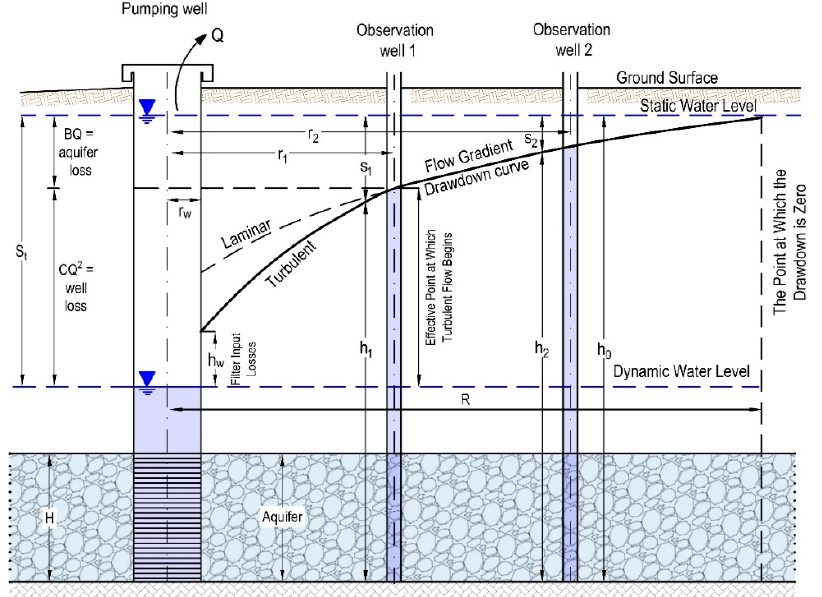
Figure 4. Drawdown in the pumping well.